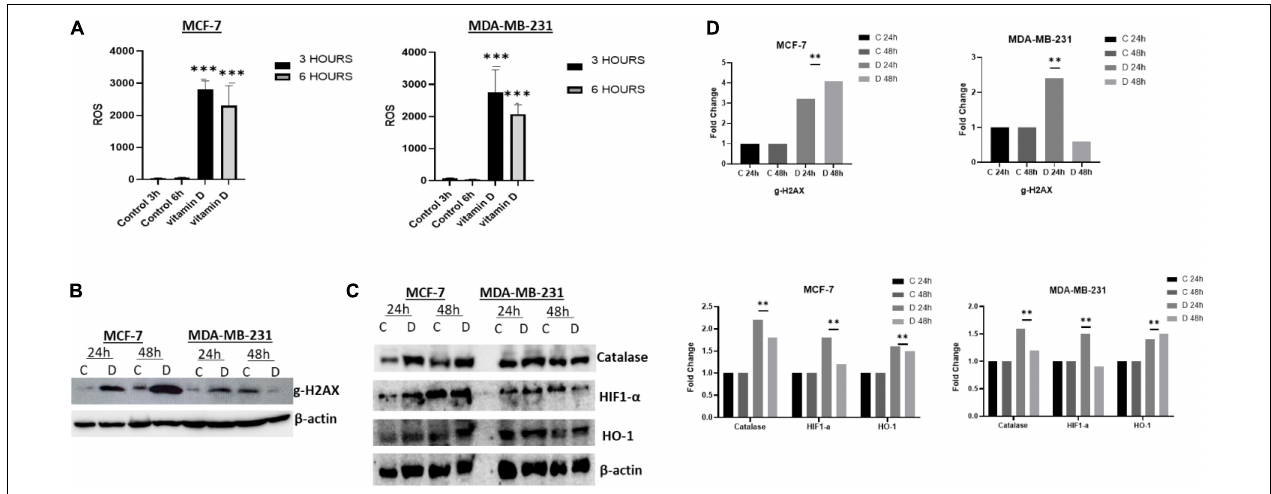
FIGURE 5 | Vitamin D alters the redox balance in BRCA cells in favor of oxidative stress. (A) ROS level expression following 3 and 6 h post vitamin D treatment. Expression of (B) the DNA damage sensor, g-H2AX, and (C) the redox balance regulators proteins catalase, Hif-1 α and OH-1 levels in MCF-7 and MDA-MB-231 cells following at 24 and 48 h post-treatment with vitamin D. The data shown are representative of three separate experiments. (D) Quantitative analysis of relative protein band density after normalization to β -actin and compared to the control. **Represents statistically significant change ( P < 0.01) and ***Represents statistically significant change ( P < 0.001).